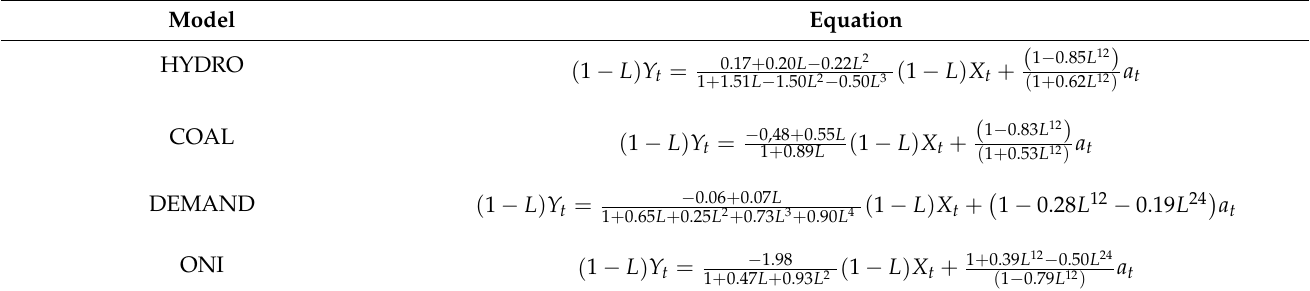
Table 6. ADL models in equation form.